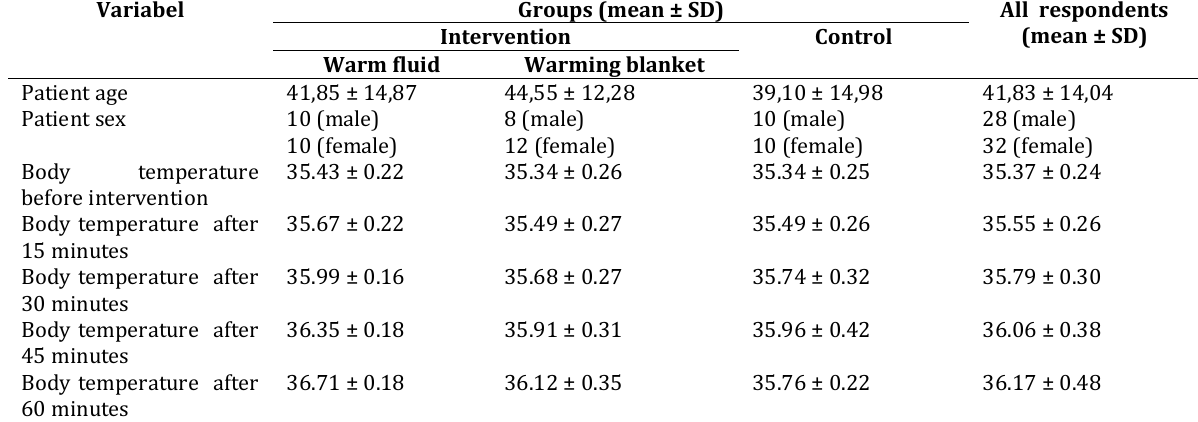
Table 2. Test results of the paired t-test in shivering patients post-spinal anesthesia Intervention